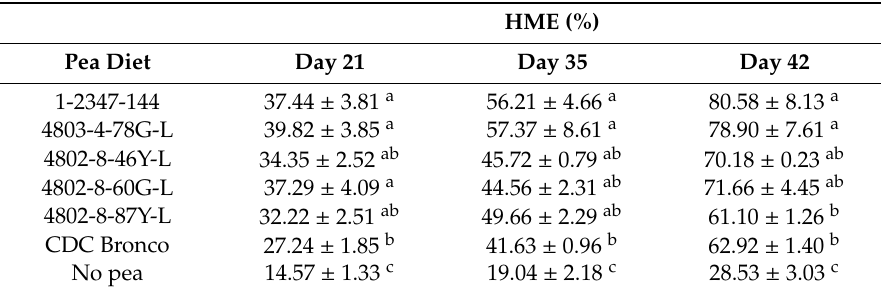
Table 8. Experimental hemoglobin maintenance e ffi cacy (HME) 1 .